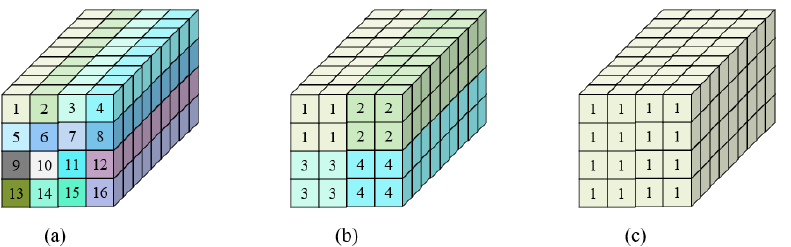
Figure 7. Data-mapping for 3 × 3 convolution. ( a ) Case for 4-bit, which completes 16 convolutions in total at a time with utilization 100%. ( b ) Case for 8-bit, which completes 4 convolutions in total at a time with utilization 100%. ( c ) Case for 16-bit, which completes 1 convolution in total at a time with utilization 100%.